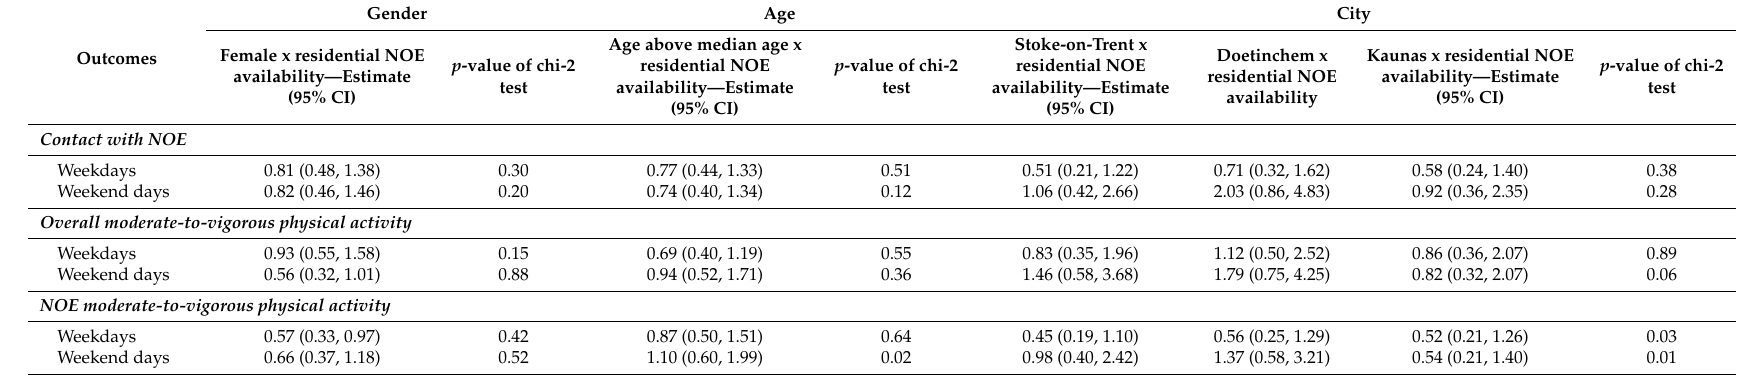
Kaunas x residential NOE p -value of chi-2 availability—Estimate test (95% CI)